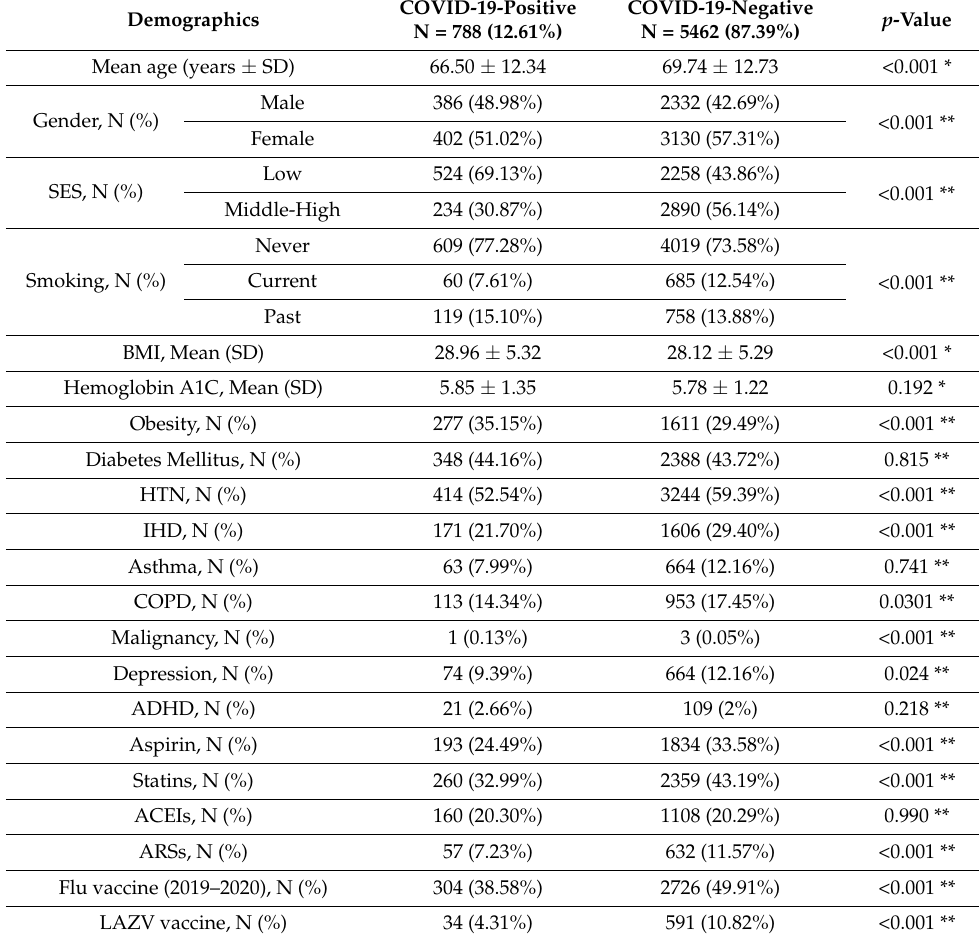
Table 2. Demographic and clinical characteristics of COVID-19-positive vs. COVID-19-negative subjects.